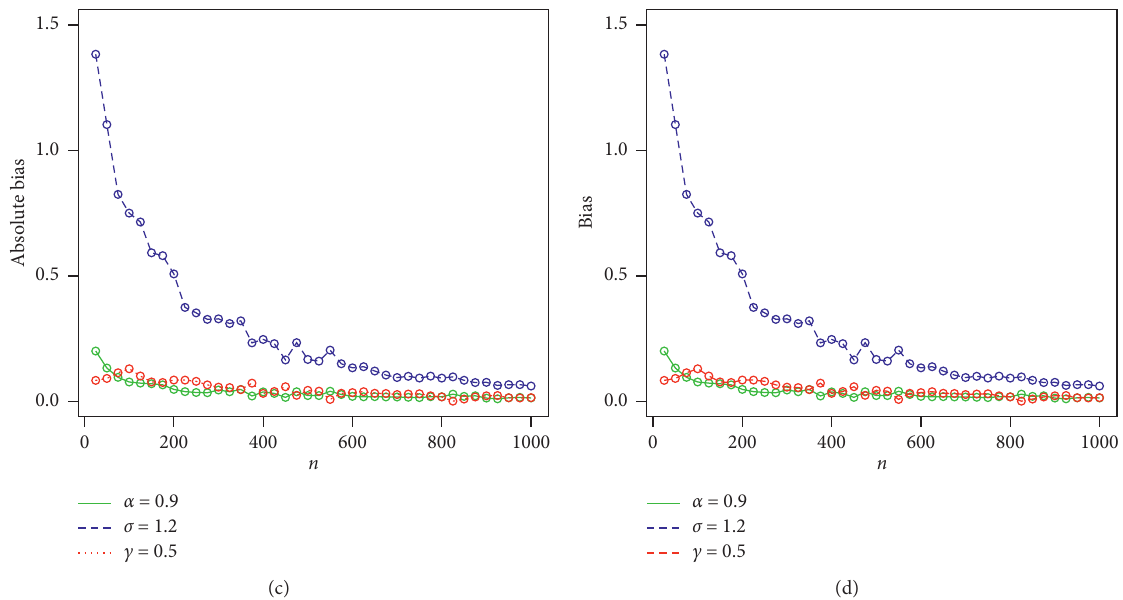
Figure 3: Plots of the estimated parameters, MSEs, absolute biases, and biases for α � 0 . 9, σ � 1 . 2 � , and c � 0 . 5. (a) Plot of estimated parameters versus n . (b) Plot of MSE versus n . (c) Plot of absolute bias versus n . (d) Plot of bias versus n